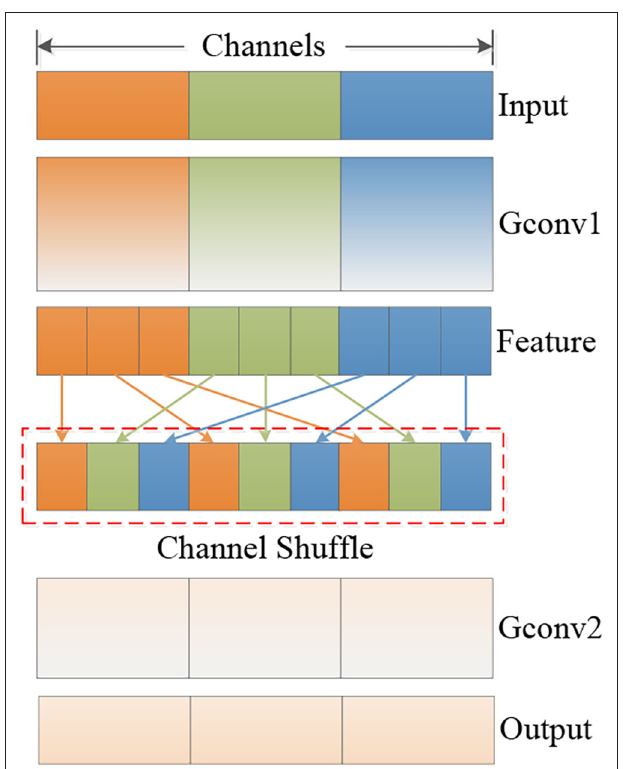
FIGURE 2 | The structure of the ShuffleNet